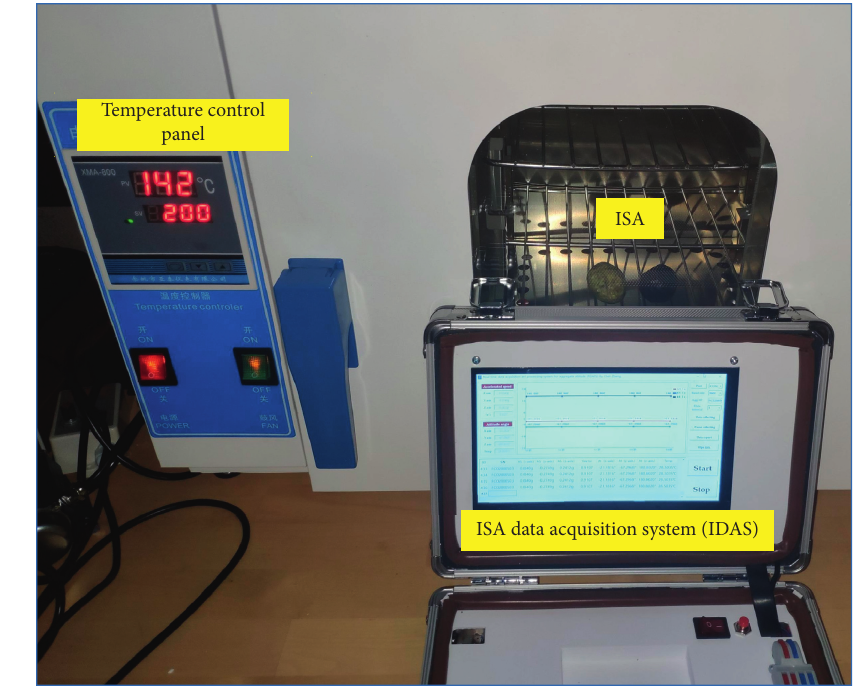
Figure 9: High-temperature resistance test of ISA.